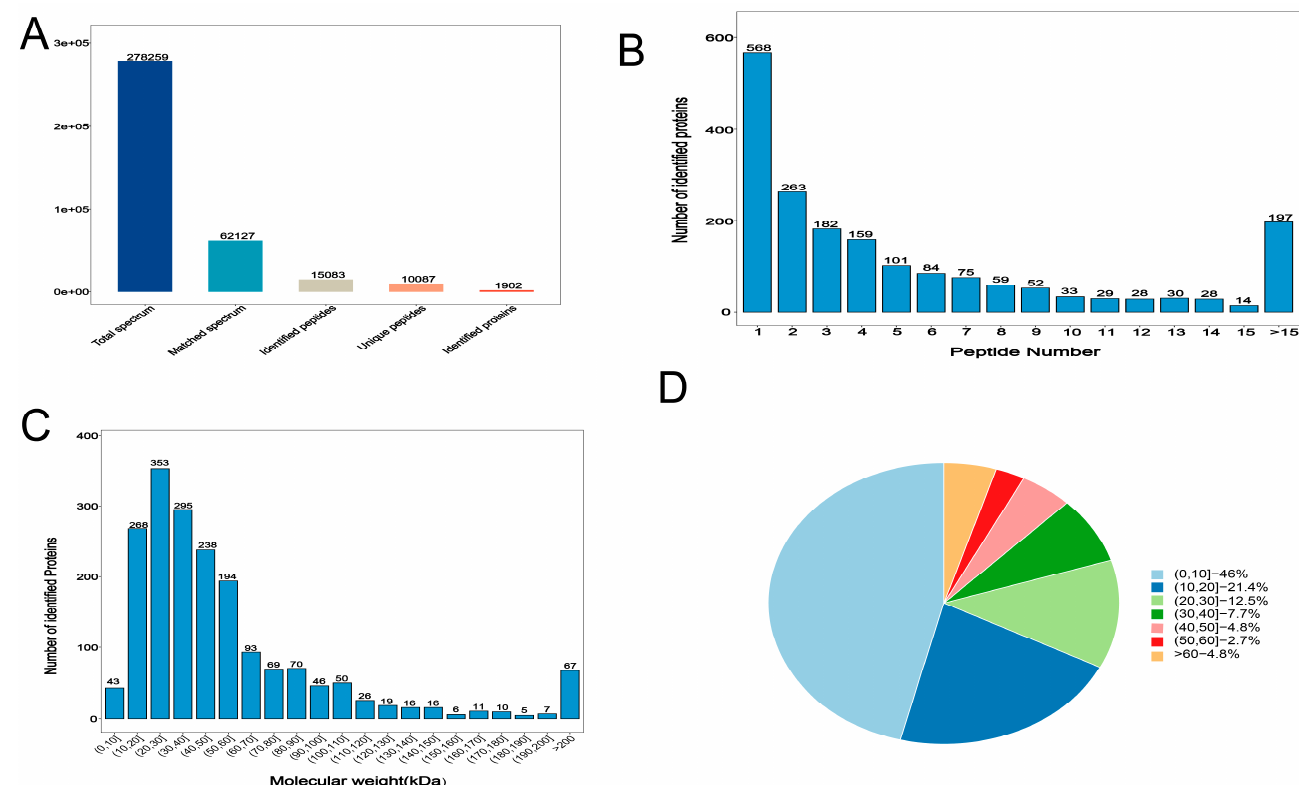
Figure 2. Identification and quantitative evaluation of proteins. ( A ) Identified spectra, peptides, and proteins. ( B ) Peptide quantity distribution ( C ) Protein molecular weight distribution ( D ) Distribution of protein sequence coverages.